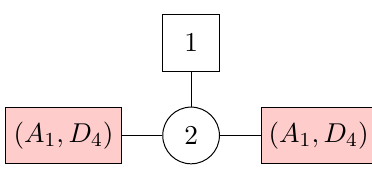
Figure 1 . The ( A 3 , A 3 ) theory is identical to the conformal SU (2) gauge theory coupled to two ( A ) theories and a fundamental hypermultiplet of SU (2) . Here, the middle circle with 2 inside 1 , D 4 stands for an SU (2) vector multiplet, and the top box with 1 inside stands for a fundamental